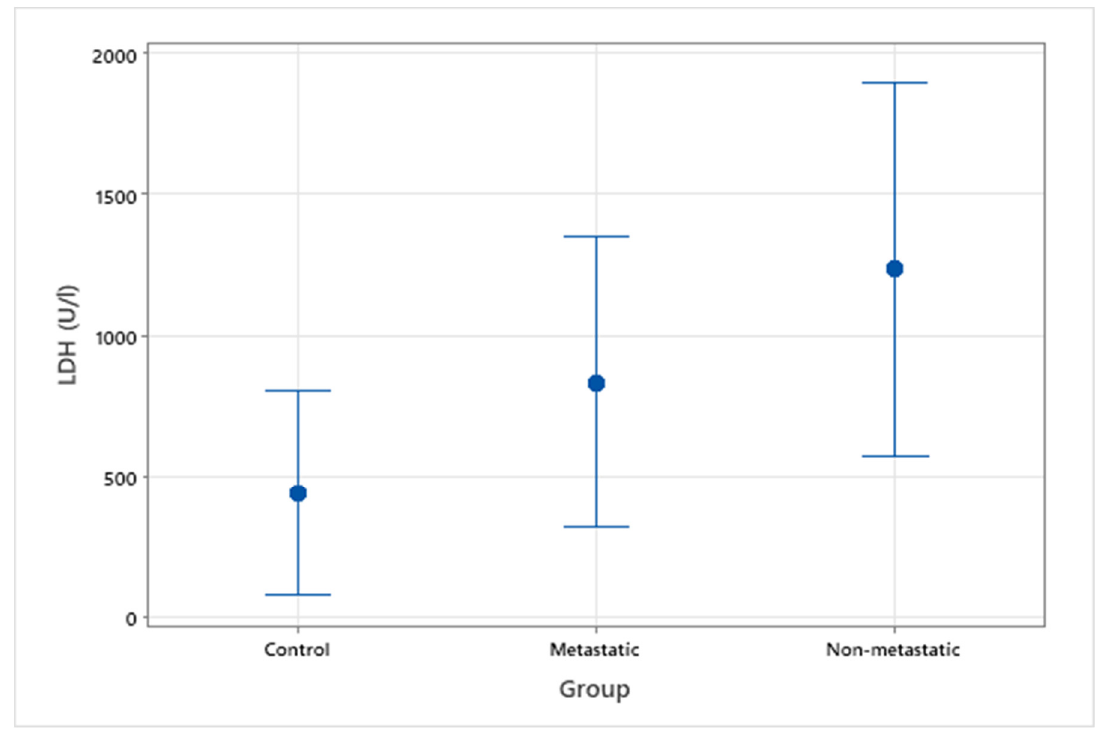
Figure 2. Interval plot of serum LDH levels (U/L) in clinically healthy dogs, patients with OMM with metastasis, and patients with OMM without metastasis.